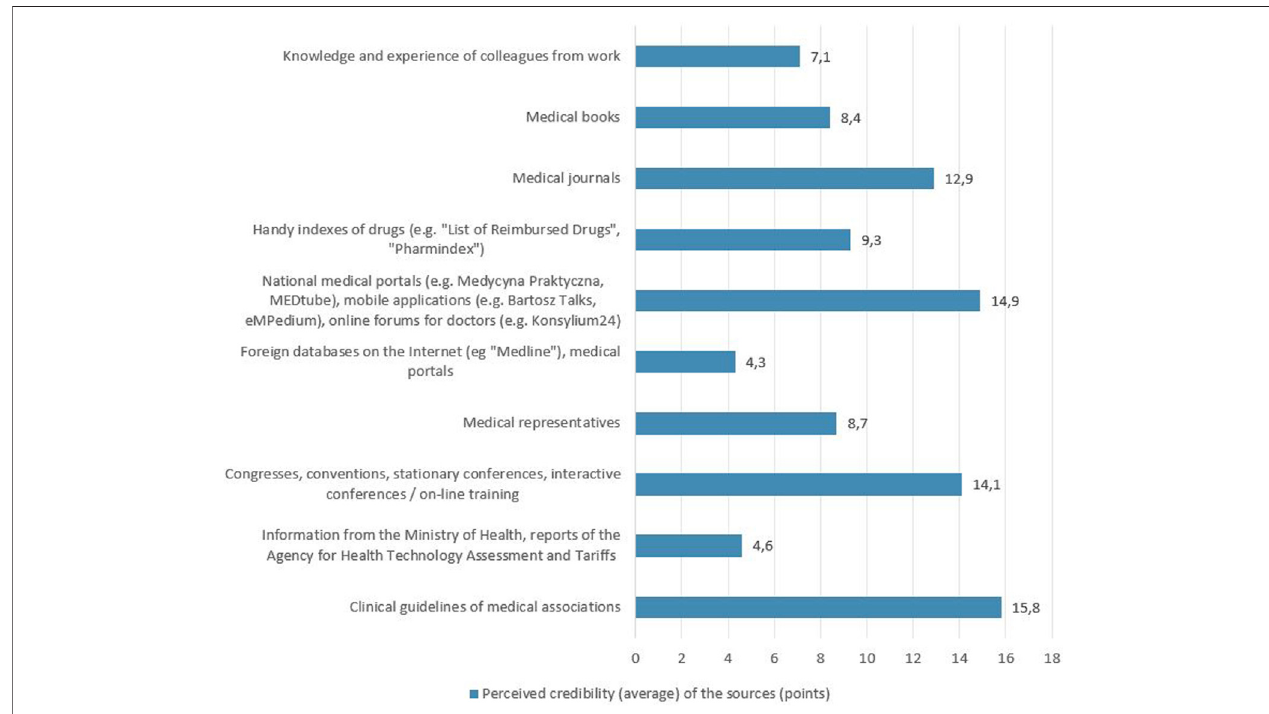
FIGURE 2 | Perceived credibility (average) of the sources of information on medicinal products as assessed by the surveyed doctors.